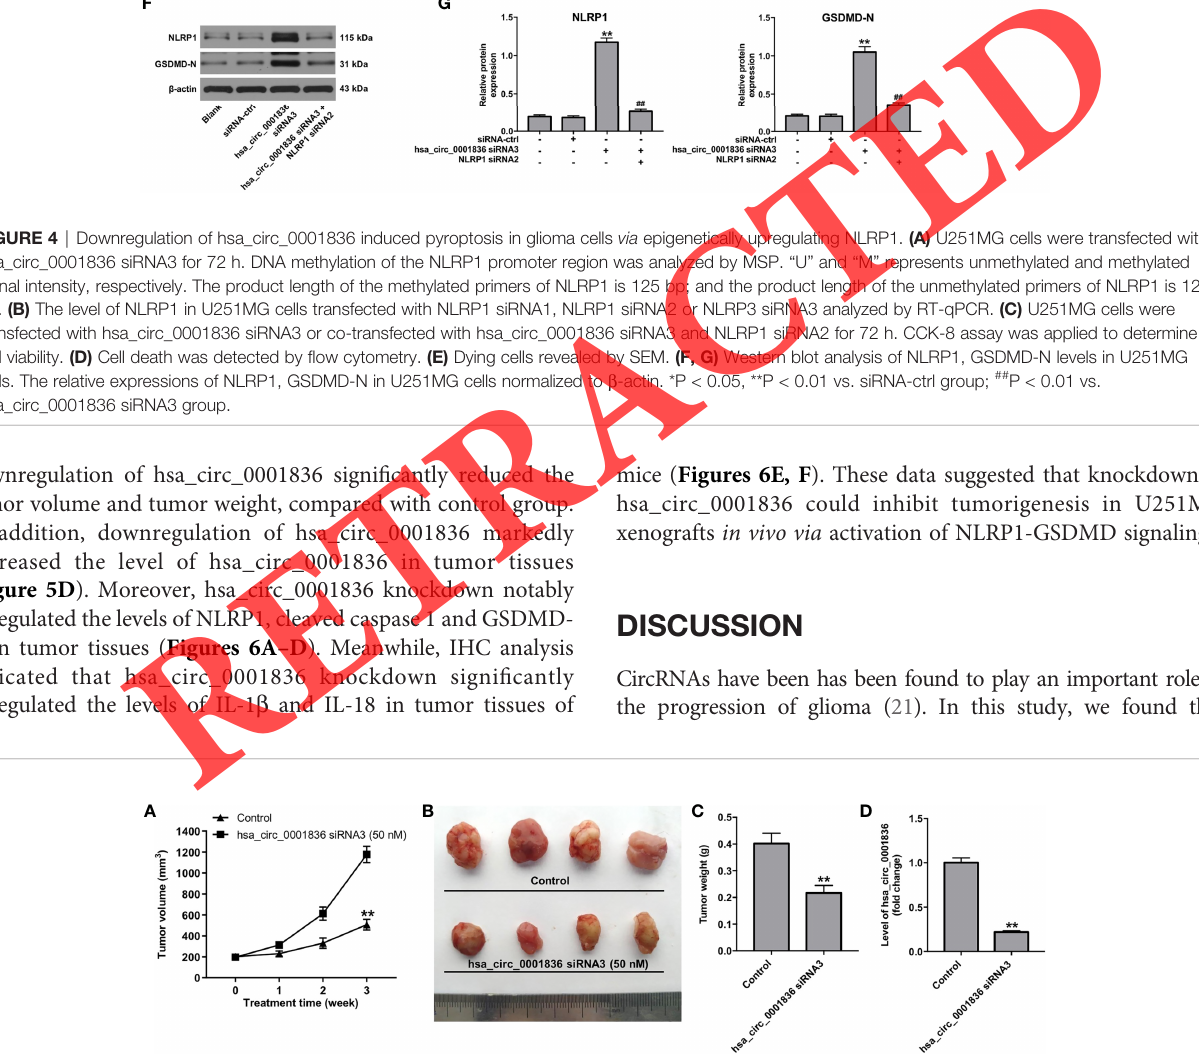
FIGURE 5 | Knockdown of hsa_circ_0001836 inhibited tumorigenesis in U251MG xenografts in vivo . (A) Xenograft tumor volume were measured weekly. (B, C) Xenografts tumors were imaged on day 21, and the tumor weights were calculated. (D) The level of hsa_circ_0001836 in tumor tissues was analyzed by RT-qPCR. **P < 0.01 vs. control